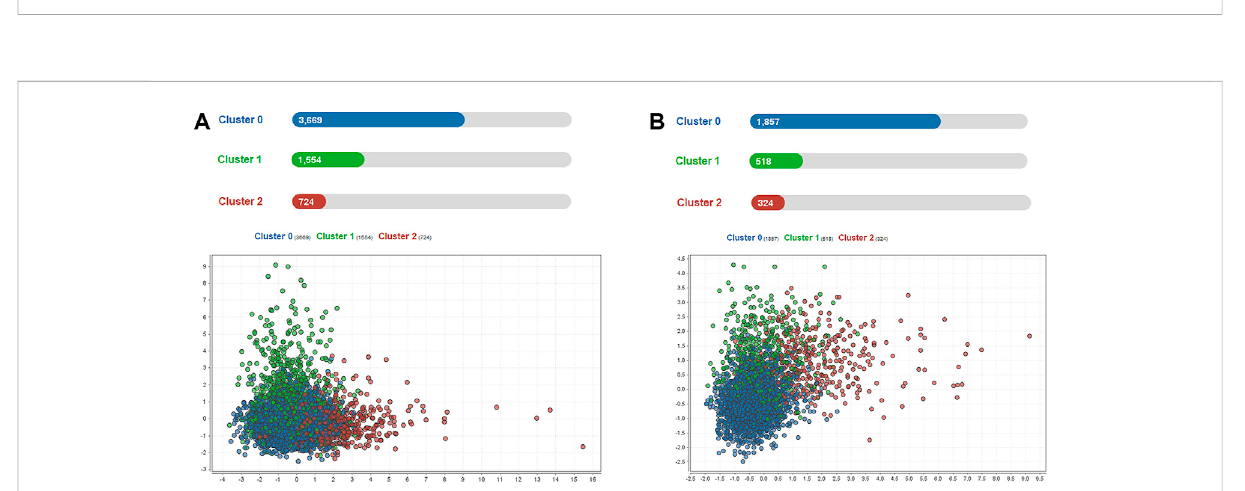
FIGURE 5 Scatter plot visualization of phenotype assignments by K-means in sepsis-associated ARDS. (A) : Scatter plot visualization of phenotype assignments by K-means in the eICU derivation cohort. There were three phenotypes, Clusters 0, 1, and 2, with 3669, 1554, and 724 patients respectively. (B) : Scatter plot visualization of phenotype assignments by K-means in the MIMIC-IV validation cohort. There were three phenotypes, Clusters 0, 1, and 2, with 1857, 518, and 324 patients